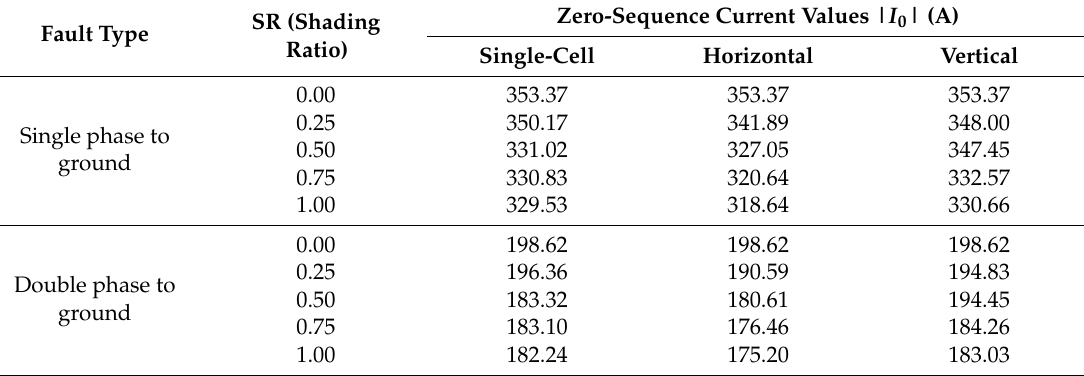
Table 3. Zero-sequence current values of partial